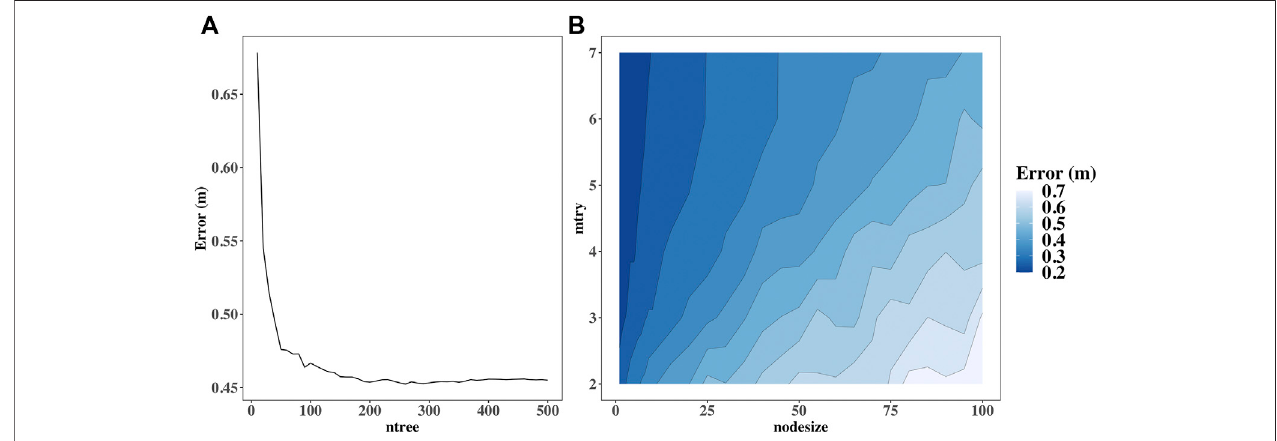
FIGURE 2 | Tune of the three key parameters in the RF model. (A) Tune of ntree and (B) tune of nodesize and mtry (A typical example for the model of wet season before the TGD operation).